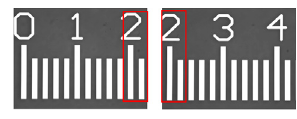
Fig. 2. Common region in two consecutive images.